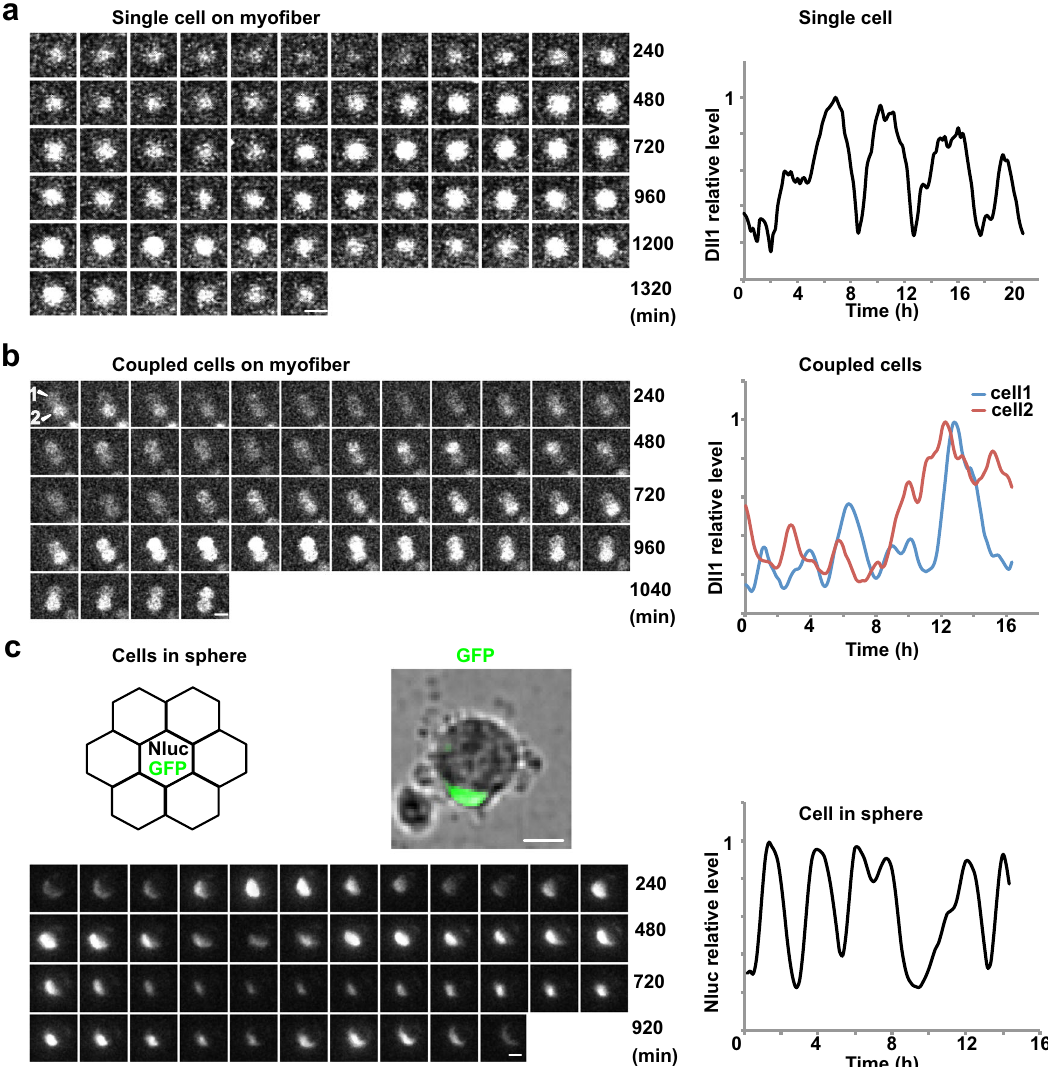
Fig. 2 Dll1 protein expression oscillates in activated muscle stem cells. a Bioluminescence images of Dll1-luciferase observed for an exemplary single muscle stem cell associated with a myo fi ber (left); imaging started after the fi ber from a Dll1 luc animal was incubated overnight. A quanti fi cation of the bioluminescence signal of this single cell is shown on the right. b Bioluminescence images of luciferase activity observed in two contacting muscle stem cells that are associated with a myo fi ber; the fi ber was obtained from a Dll1 luc animal. Imaging started after the fi ber was incubated for 42 h. Quanti fi cations of the bioluminescence signals observed in each of the two cells is shown on the right. c Schematic drawing of cells grown in a sphere; a single cell that is co-transfected with EpDll1-NanoLuc and nGFP expression plasmids is surrounded by many untransfected cells (upper left). NanoLuc bioluminescence signals detected in the single GFP + muscle stem cell in a sphere (lower left); the cell is shown in the bright fi eld image above. Quanti fi cation of the NanoLuc bioluminescence signal detected in this cell (lower right). Scale bars, 15 μ